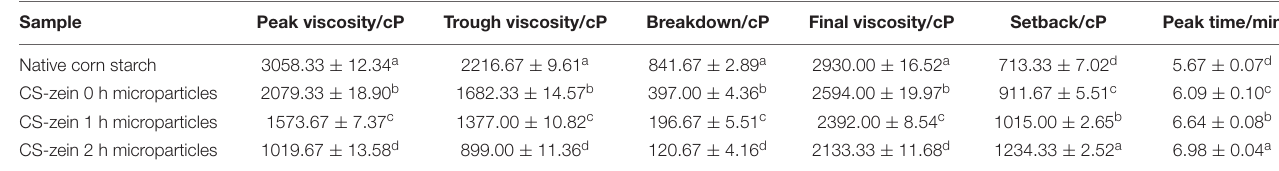
Values indicate means ± SD of three replicates. Data in the same column with different letters are substantially different (p < 0.05).